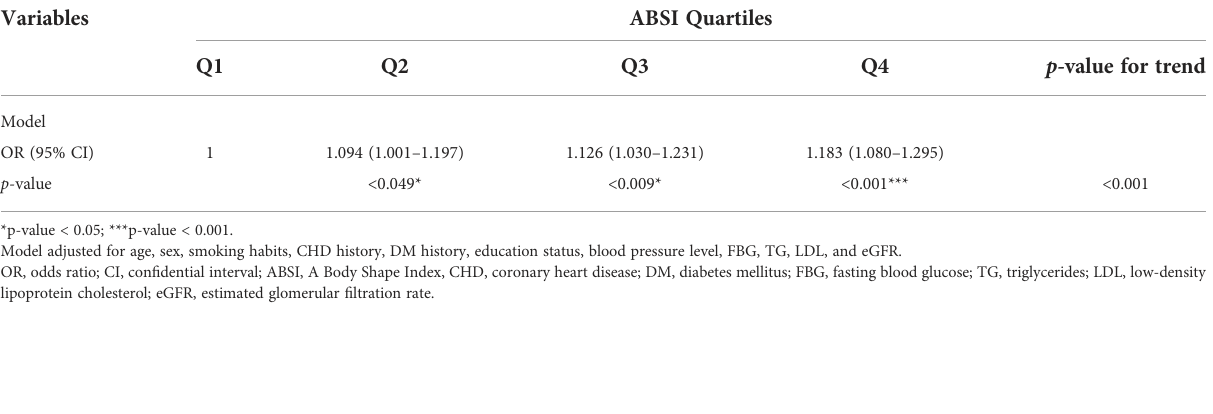
TABLE 2 Association between ABSI quartiles and UACR in the total